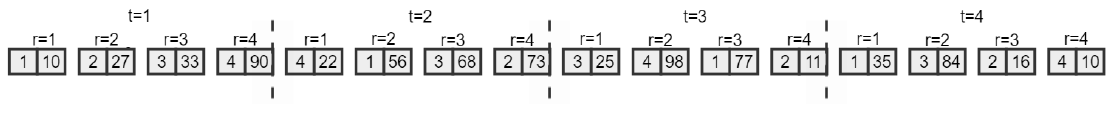
Fig. 1. An example for SA solution